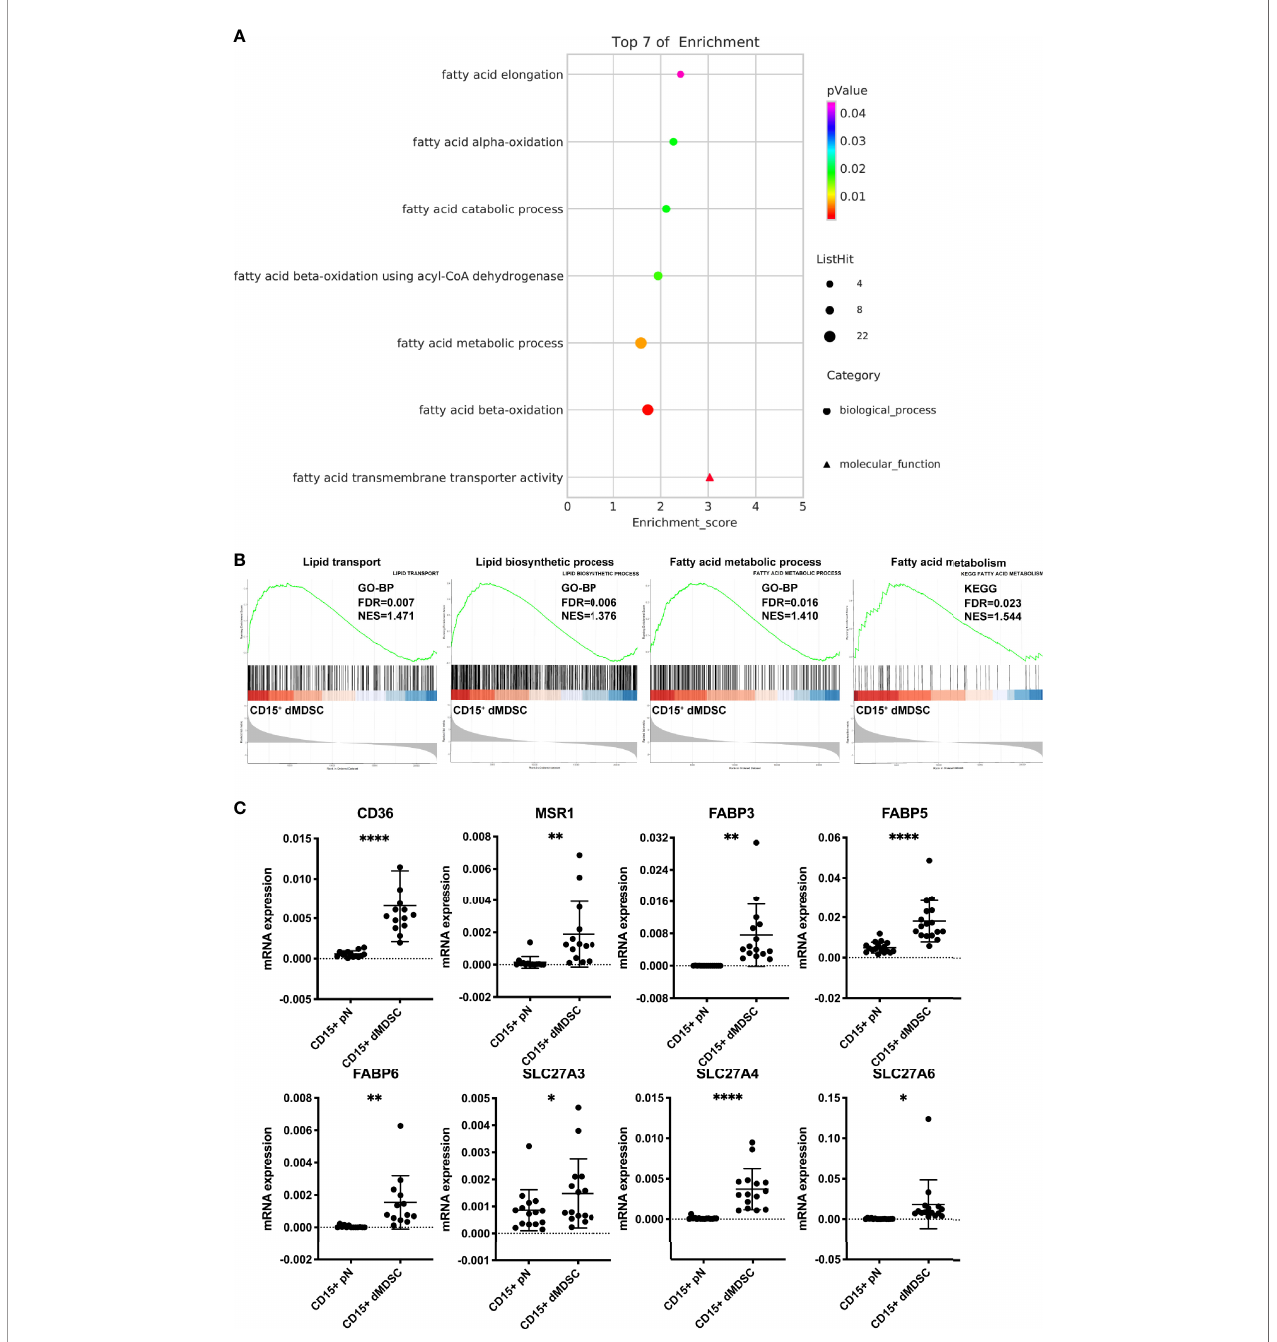
FIGURE 2 | Upregulation of fatty acid transmembrane transporter activity in decidual PMN-MDSCs. (A) GO enrichment analysis of lipid-related pathways in decidual PMN-MDSCs and autologous neutrophils in healthy women during early pregnancy (n = 3). (B) GSEA showed that gene sets related to lipid metabolism were highly enriched in CD15+ dMDSCs, including lipid transport, lipid biosynthetic process, fatty acid metabolic process (GO term), and fatty acid metabolism (KEGG pathway). (C) The differential expression of lipid transport receptors was detected between CD15+ dMDSCs and autologous pN in NP, including CD36, MSR1, FABP3, FABP5, FABP6, SLC27A3, SLC27A4, SLC27A5, and SLC27A6. All data are presented as mean ± SD. Signi fi cance was determined by unpaired Student ’ s t-test. ****p < 0.0001, **p < 0.01, *p <